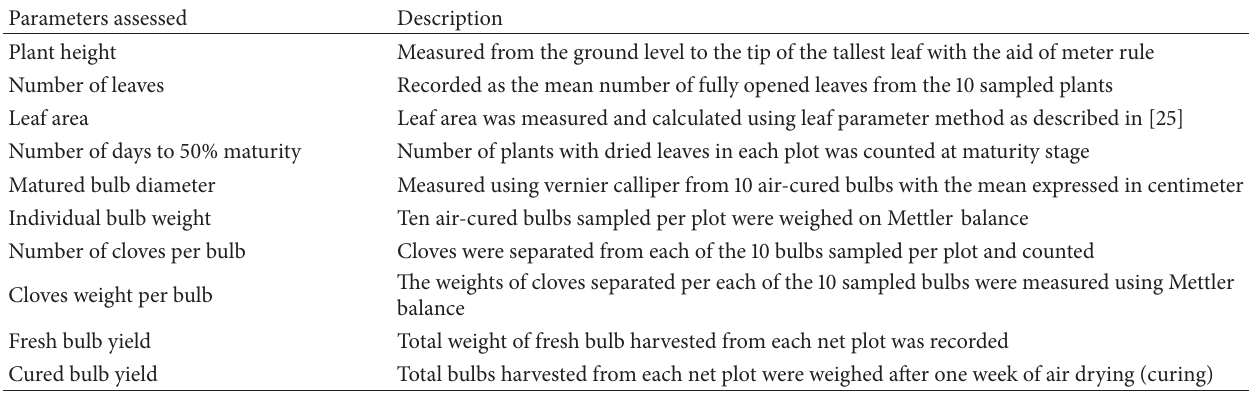
Table 1: Description of characters assessed during the study.